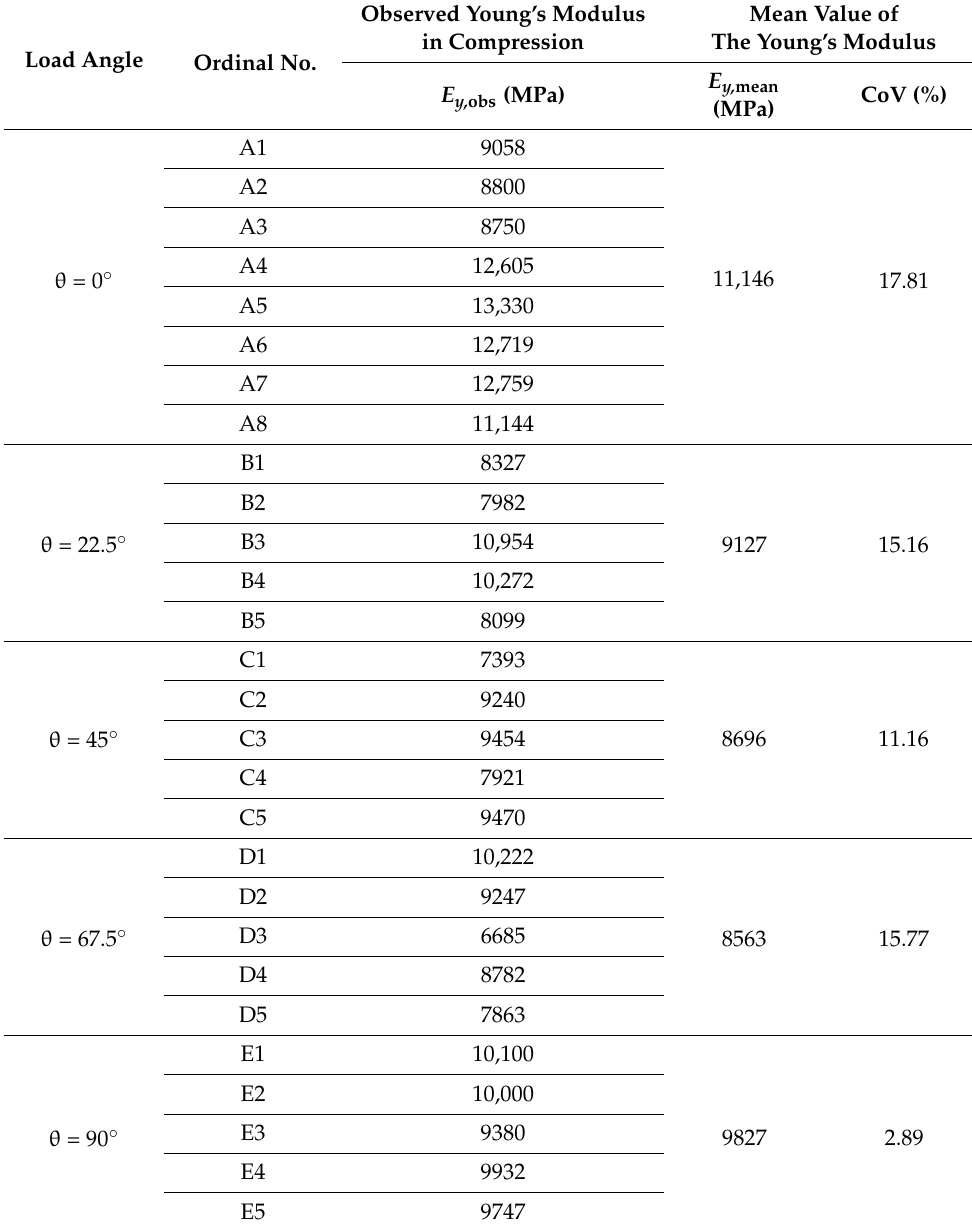
Table 3. Young’s modulus test results of wall samples with different angle of bed joints θ